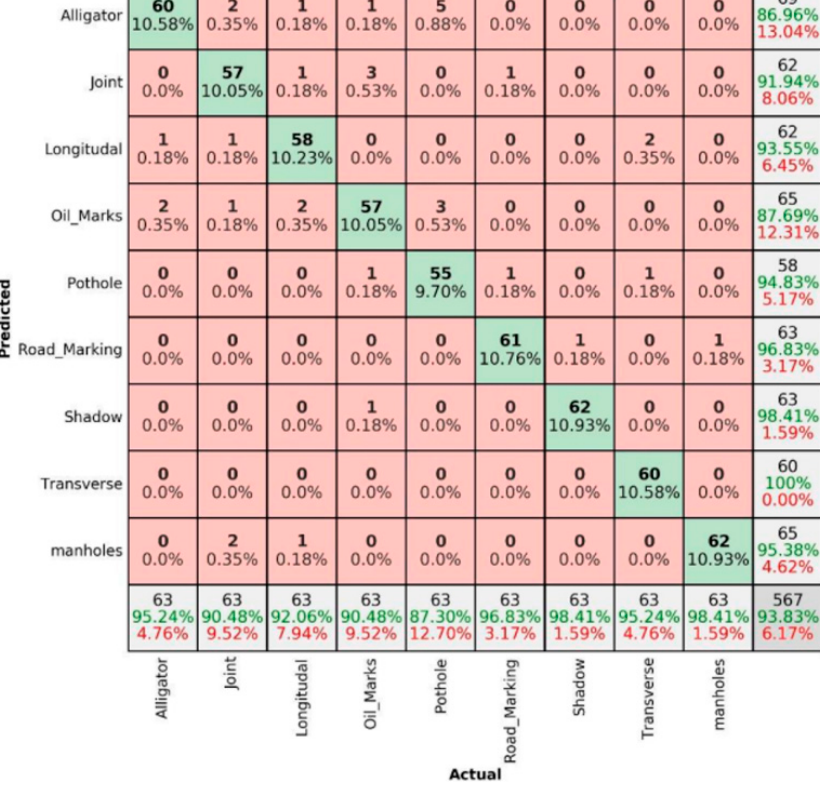
Figure 9. Summer sunny condition—IR-T images.